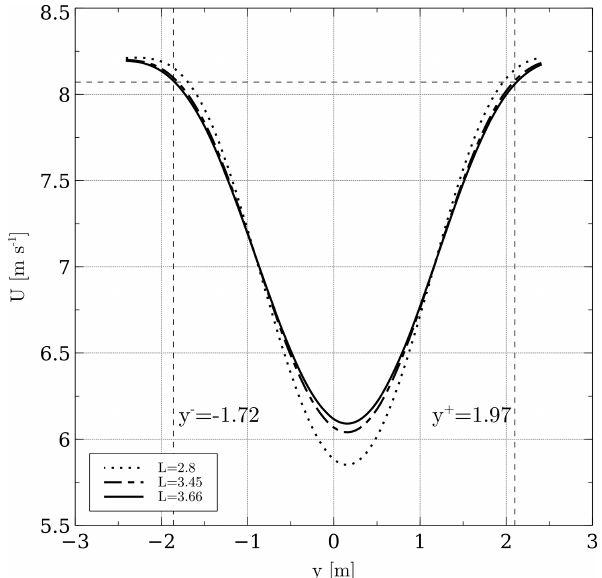
Figure 9. Wake widths obtained by following an iterative proce- dure. All the plots are located at 7 D